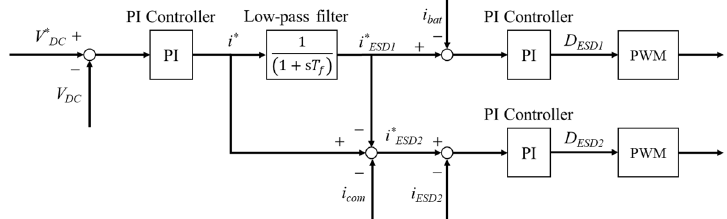
Figure 2. Block diagram of the low-pass filter controller.